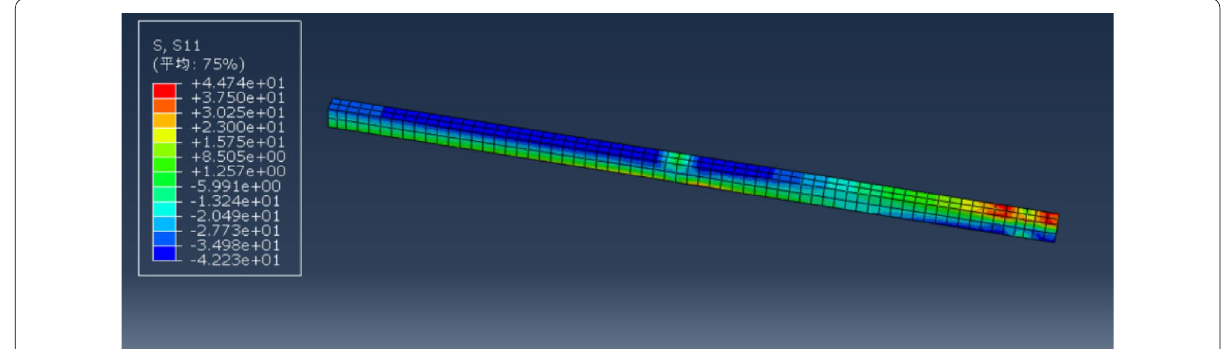
Fig. 18 Diagrammatic sketch of the stress